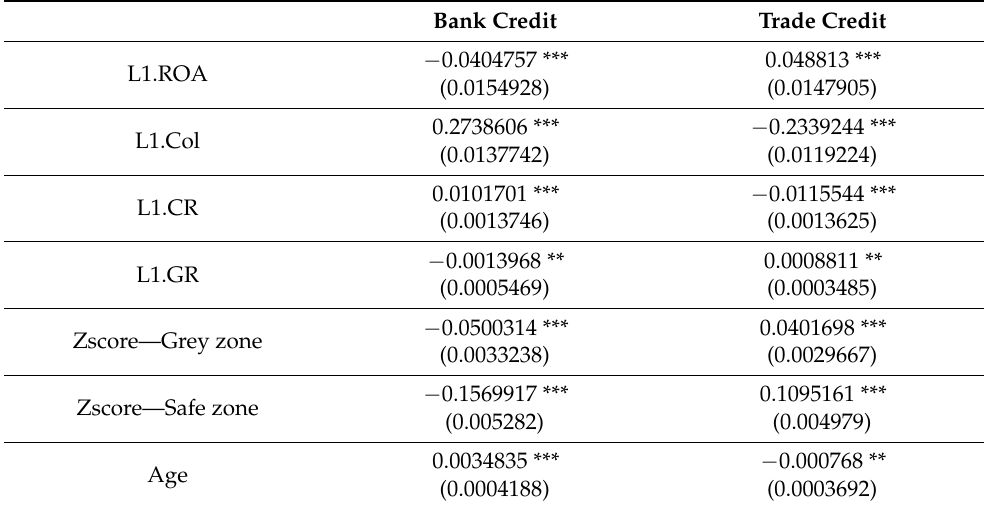
Table 5. Fixed-effects models with lagged independent